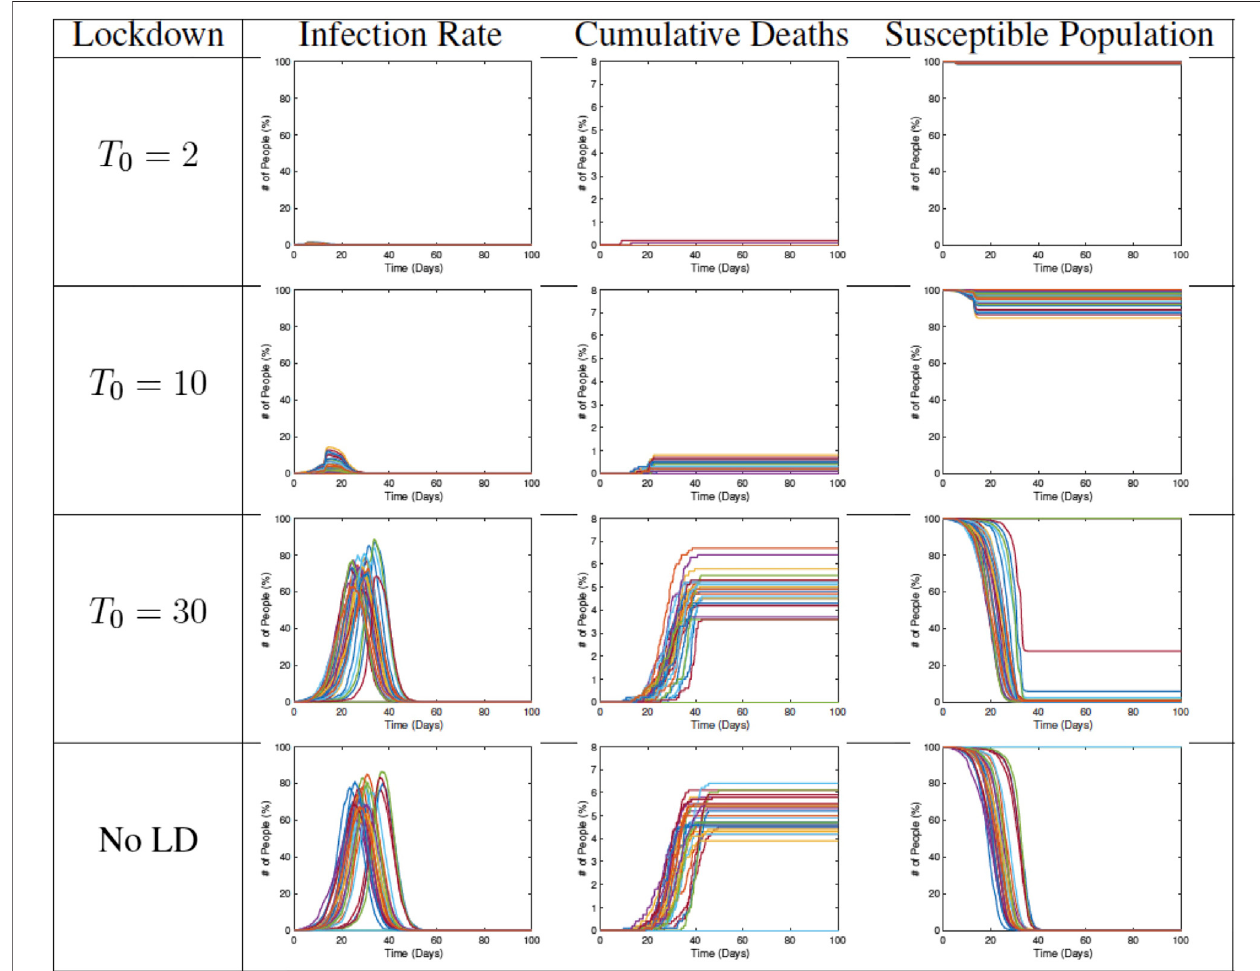
FIGURE12| ResultsfromRAW-ALPSrunsforafulllockdown(LD1)startingatdifferenttimes.Goingfromtoptobottom,weimposelockdownslaterandlater.The effect of a lockdown diminishes signi fi cantly if the start of the lockdown is delayed.